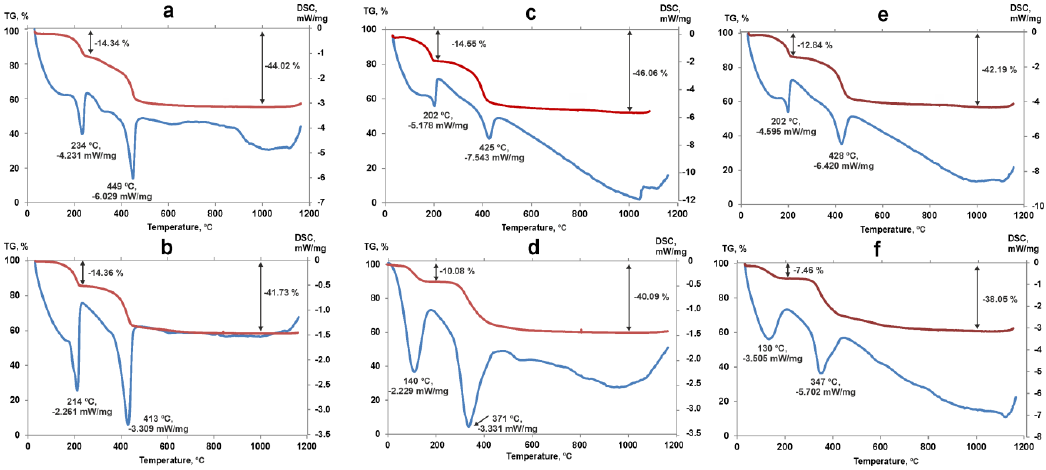
Figure 5. DSC and TG curves of quintinite ( a ), hydrotalcite ( b ), stichtite ( c ), iowaite ( d ), annealed hydrotalcite, sample htc125 ( e ) and annealed iowaite, sample iow125 ( f ). Table 2. Chemical composition of quintinite, hydrotalcite, stichtite, and iowaite obtained by electron-microprobe analyses of polished sections.